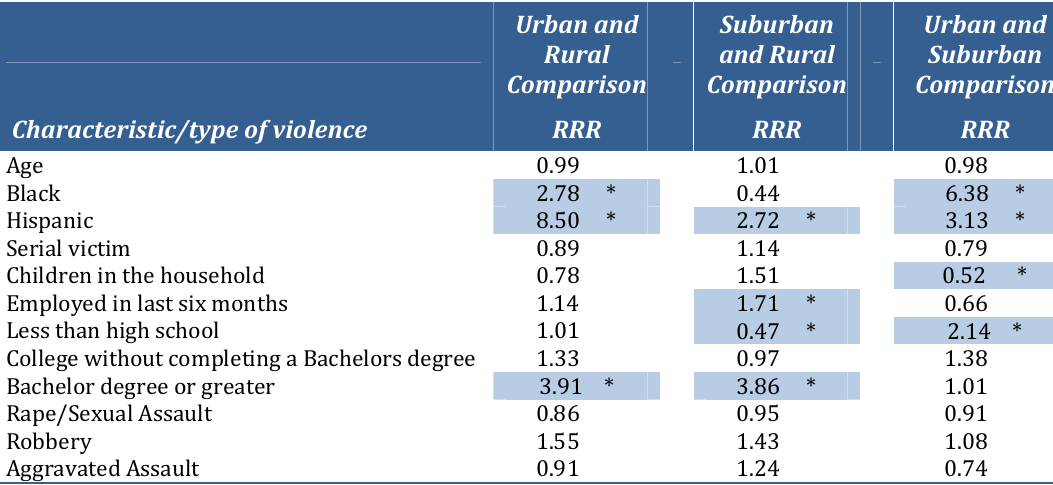
Urban and Suburban Comparison